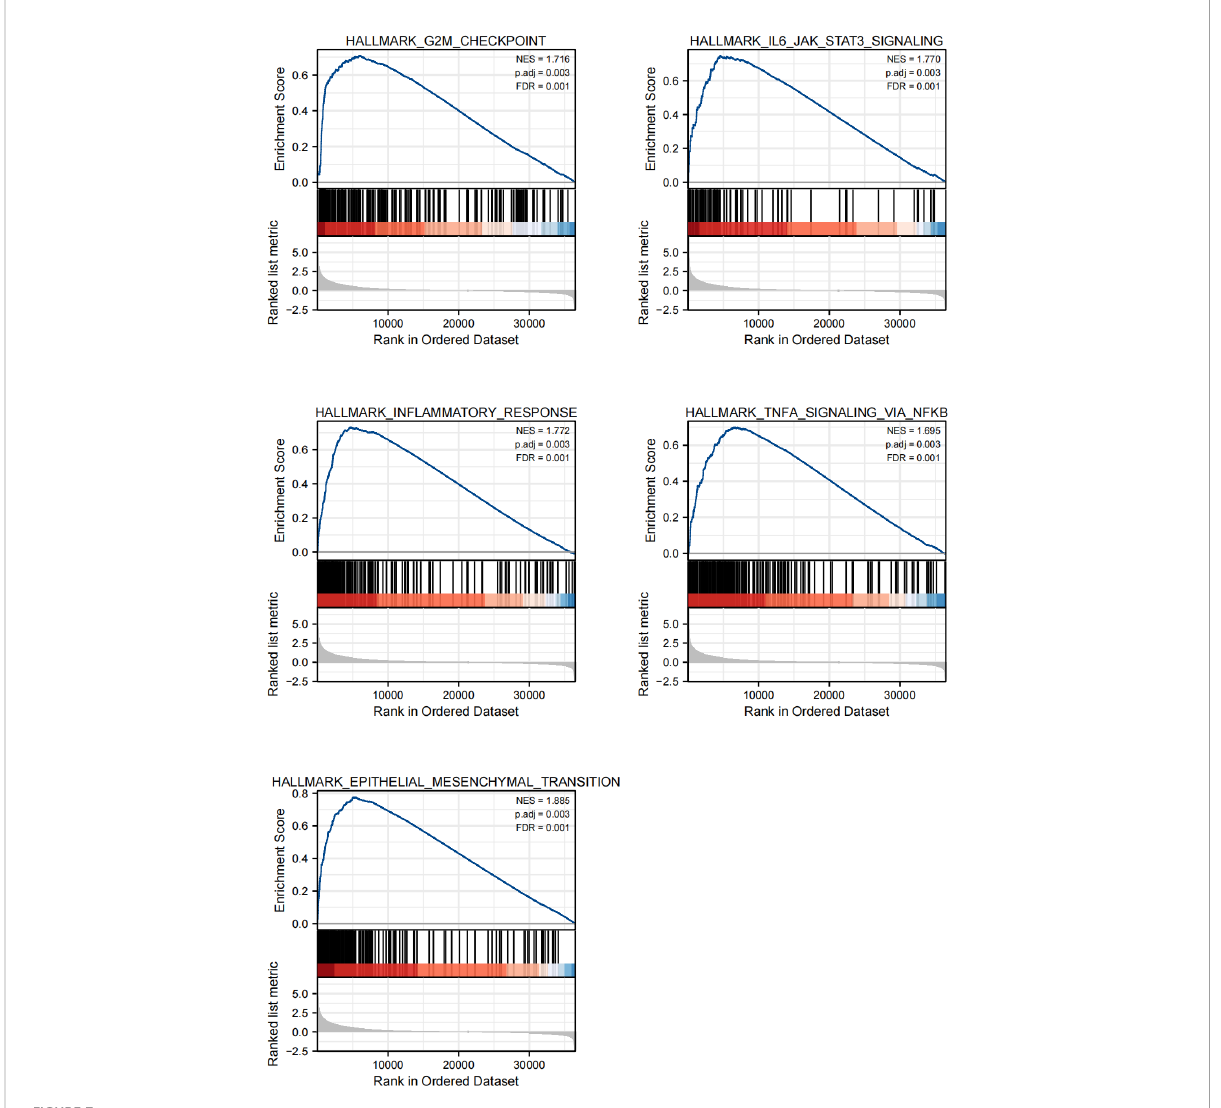
FIGURE 7 GSEA of the SnG-signature. G2M checkpoint, IL6/JAK/STAT3 signaling, In fl ammatory response, TNF a signaling via NF k B, Epithelial mesenchymal